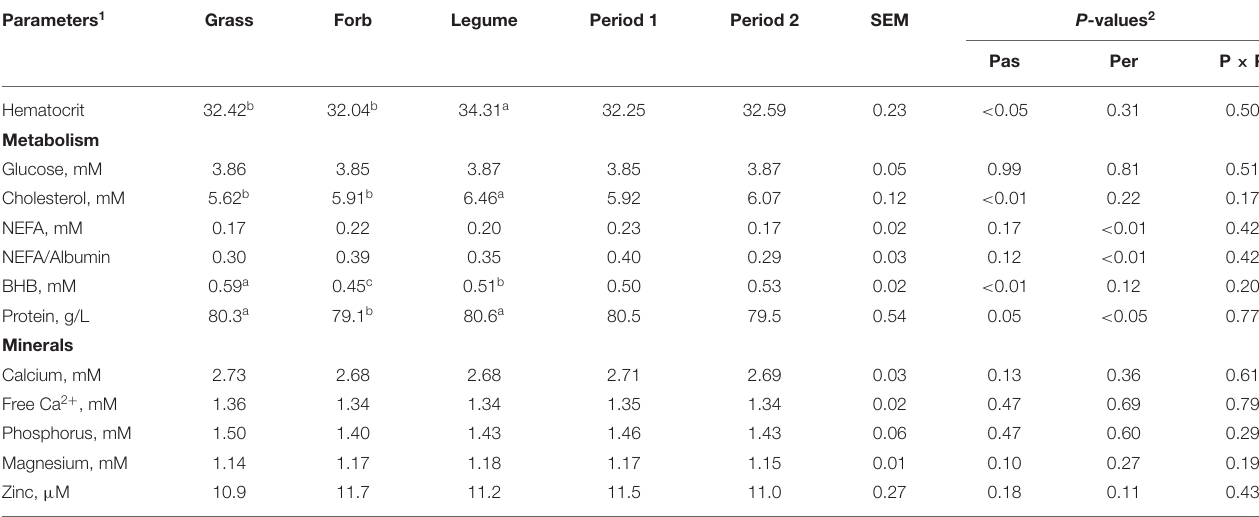
TABLE 1 | The blood parameters associated with metabolism and mineral concentration in the dairy cows grazing Grass-, Forb-, or Legume-based pastures. Parameters 1 Grass